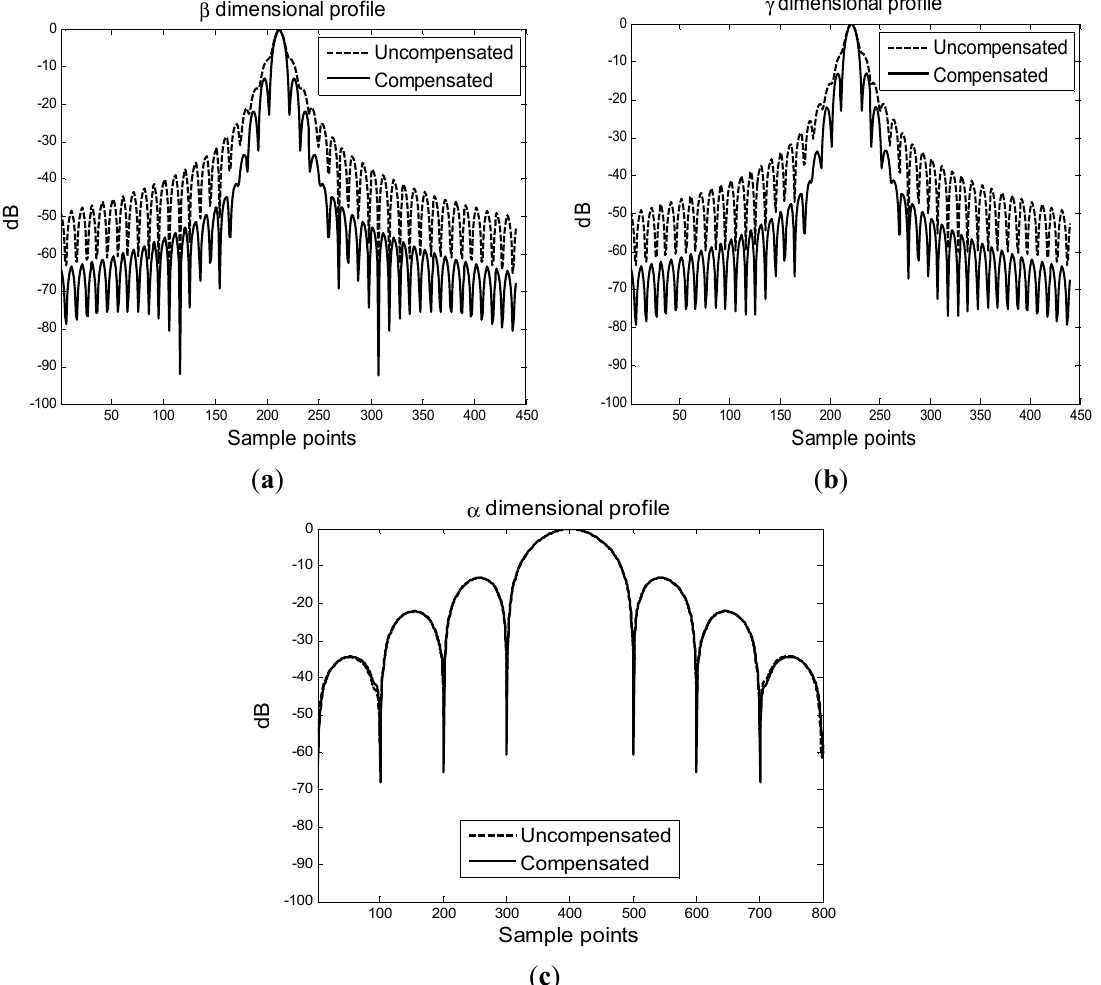
Figure 13. Profile analysis: ( a ) β dimensional profile with and without compensation. ( b ) γ dimensional profile with and without compensation. ( c ) α dimensional profile with and without compensation.